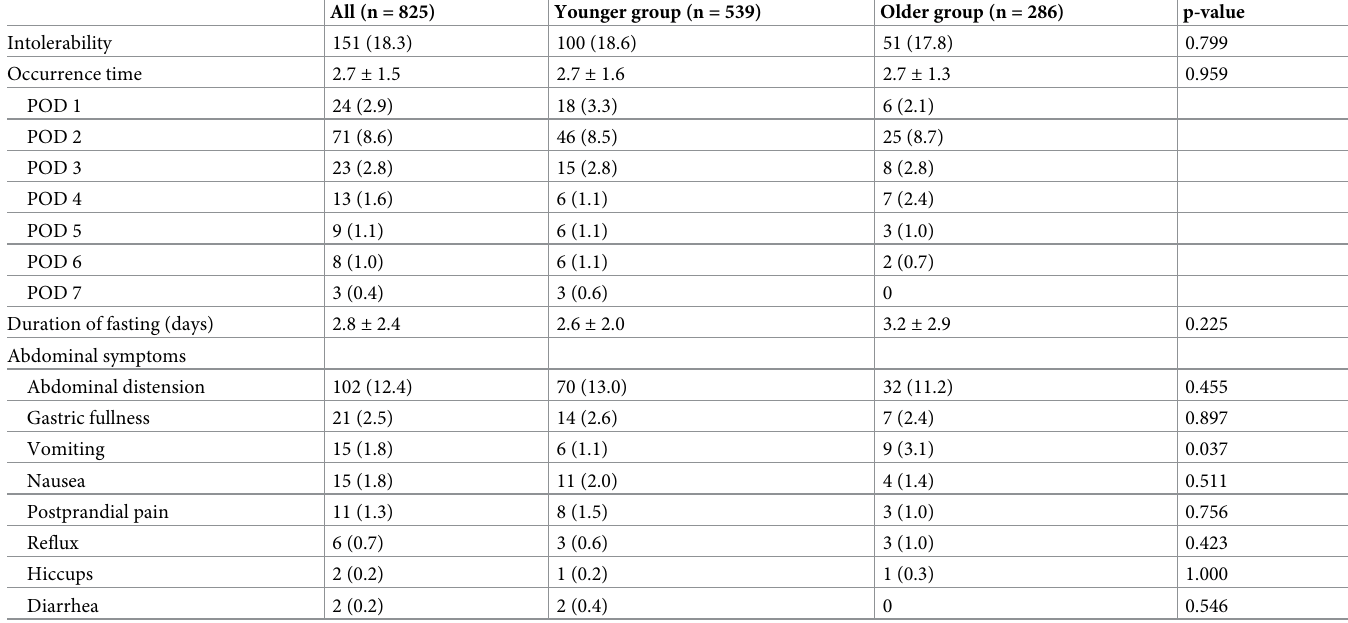
Table 2. Intolerability to early oral